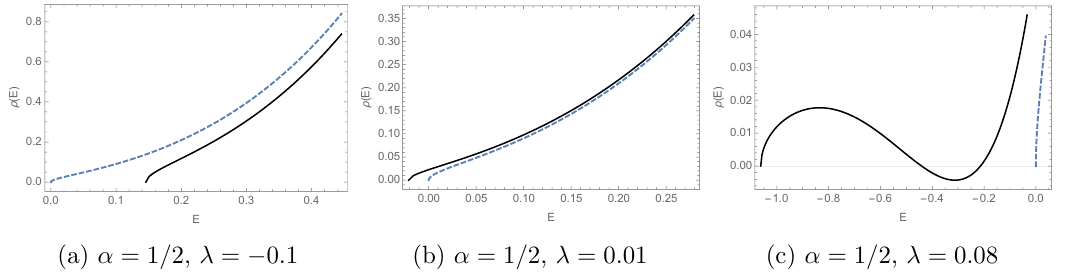
Figure 2 . Density of states of JT gravity with (black) and without (dashed blue) defects, for 2 (cid:13) = 1. (a) For (cid:11) = 1 = 2 < (cid:11) c and (cid:21) = (cid:0) 0 : 1 < 0 we see E 0 > 0 as expected and the theory is